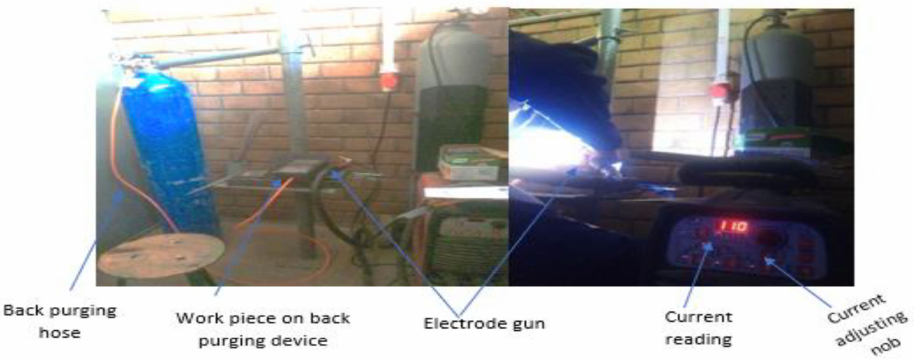
Figure 4. GTAW welding setup (Centre of Excellence for Engineering, Addis Ababa,